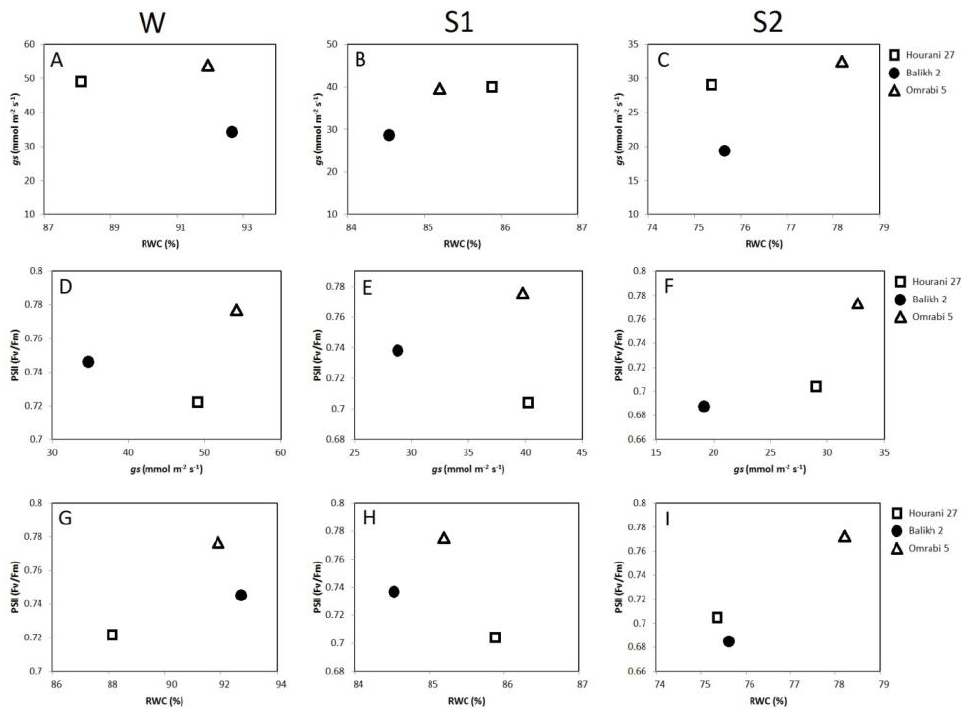
Figure 3. Relationship between pairs of physiological parameters in wheat for RWC vs. stomatal conductance ( A – C ), stomatal conductance vs. PSII activity ( D – F ) and RWC vs. PSII activity ( G – I ) in three durum wheat cultivars. Column panels ( A , D , G ), ( B , E , H ) and ( C , F , I ) represent W, S1 and S2, respectively.